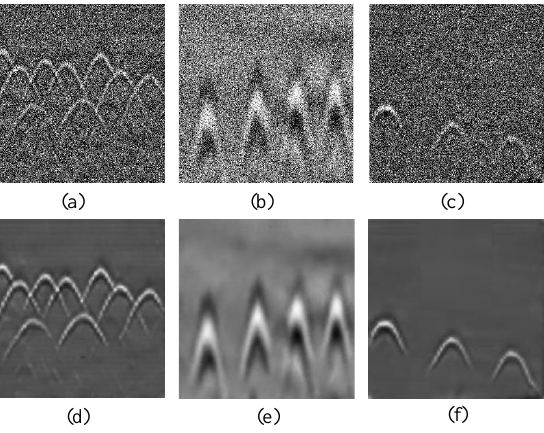
Figure 6. The denoised results of MCAE algorithm. ( a ) Simulated noisy image (PSNR: 11.23 dB). ( b ) Field noisy image (PSNR: 11.25 dB). ( c ) Generated noisy image (PSNR: 11.28 dB). ( d ) Simulated image denoised by MCAE (PSNR: 30.18 dB). ( e ) Field image denoised by MCAE (PSNR: 32.41 dB). ( f ) Generated image denoised by MCAE (PSNR: 31.82 dB).